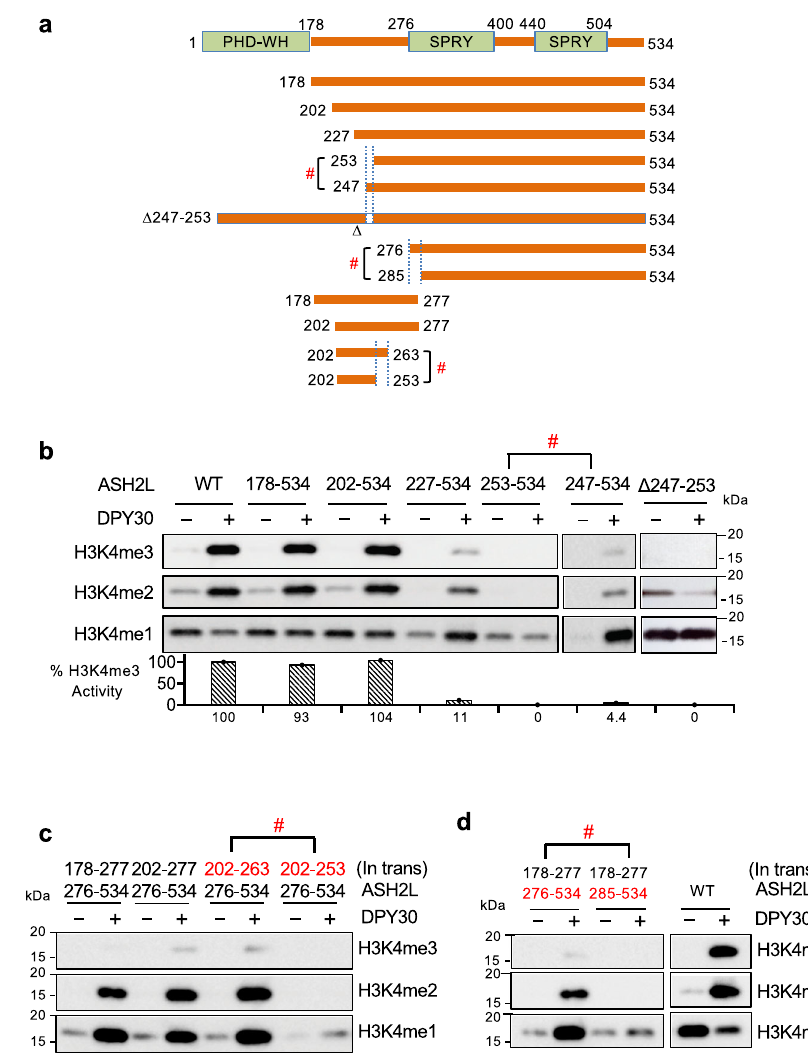
Fig. 3 Identi fi cation of essential ASH2L IDRs in DPY30-mediated stimulation. a Human ASH2L deletion mutants used in ( b – d ) and transactivation peptides used in ( c ) and ( d ) . b Serial deletion to map essential ASH2L Linker IDRs for DPY30 function. In vitro HMT assay for the MLL1 core complex containing wild-type or various ASH2L mutants as indicated on top. The assays were performed in the presence or absence of DPY30. c – d Trans-activation experiments using two fragments of ASH2L in the in vitro HMT assay. The MLL1 core complexes containing a mixture of two stoichiometric ASH2L fragments were used with or without DPY30 as indicated on top. #, indicates abolishment of DPY30-dependent activity. Quanti fi cation completed using ImageJ 108 with %activity calculated relative to wild-type